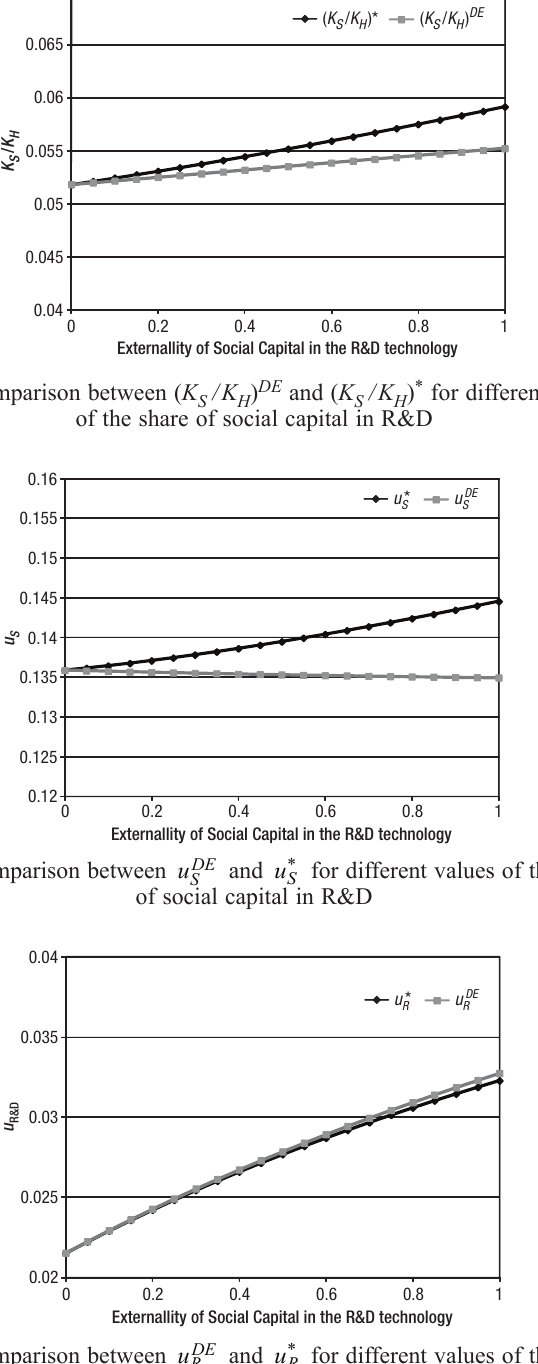
u and * u for different values of the R R